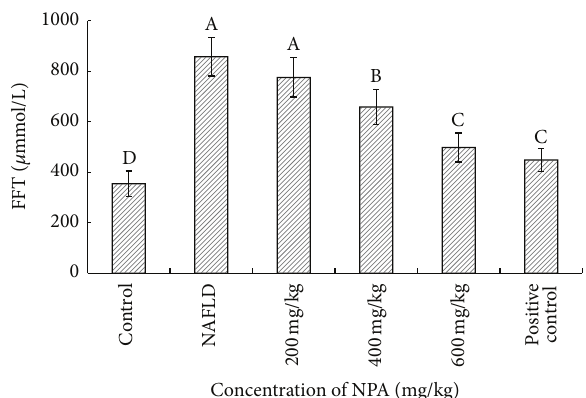
Figure 2: Effect of different concentrations of NPA on serum levels of FFT in each group of rats. Different letters (A, B, C, or D) upon each column represent significant differences between the treated groups ( 𝑃 < 0.05 ).